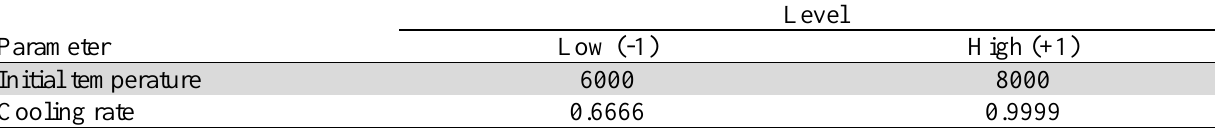
Levels of Parameters for the SA Algorithm